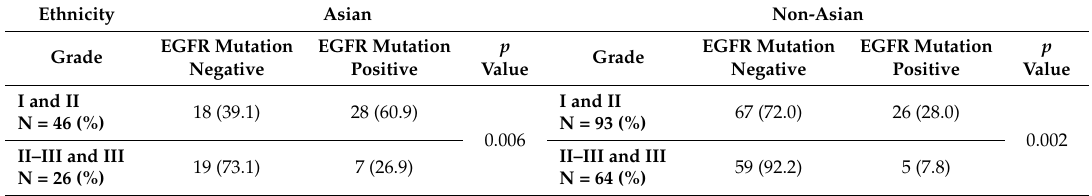
Table 3. Incidence of EGFR mutation by histologic grade and ethnicity in metastatic lung adenocarcinoma. Ethnicity Asian Non-Asian EGFR Mutation EGFR Mutation Negative Positive